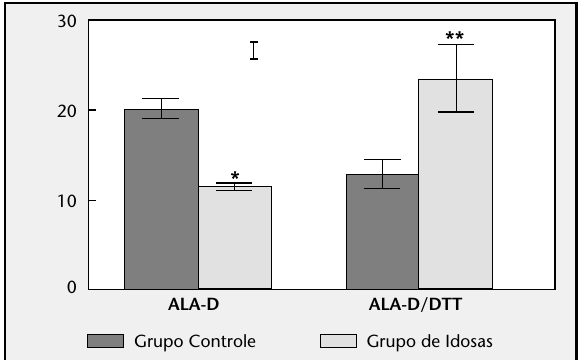
Figura 2 – Atividade da ALA-D e índice de reativação enzimática na presença de DTT (ALA-D/DTT) *Atividade da ALA-D significativamente diferente do grupo controle ( p < 0,05); **Reativação da ALA-D significativamente diferente do grupo controle ( p < 0,05). ALA-D: δ -aminolevulinato desidratase; DTT: